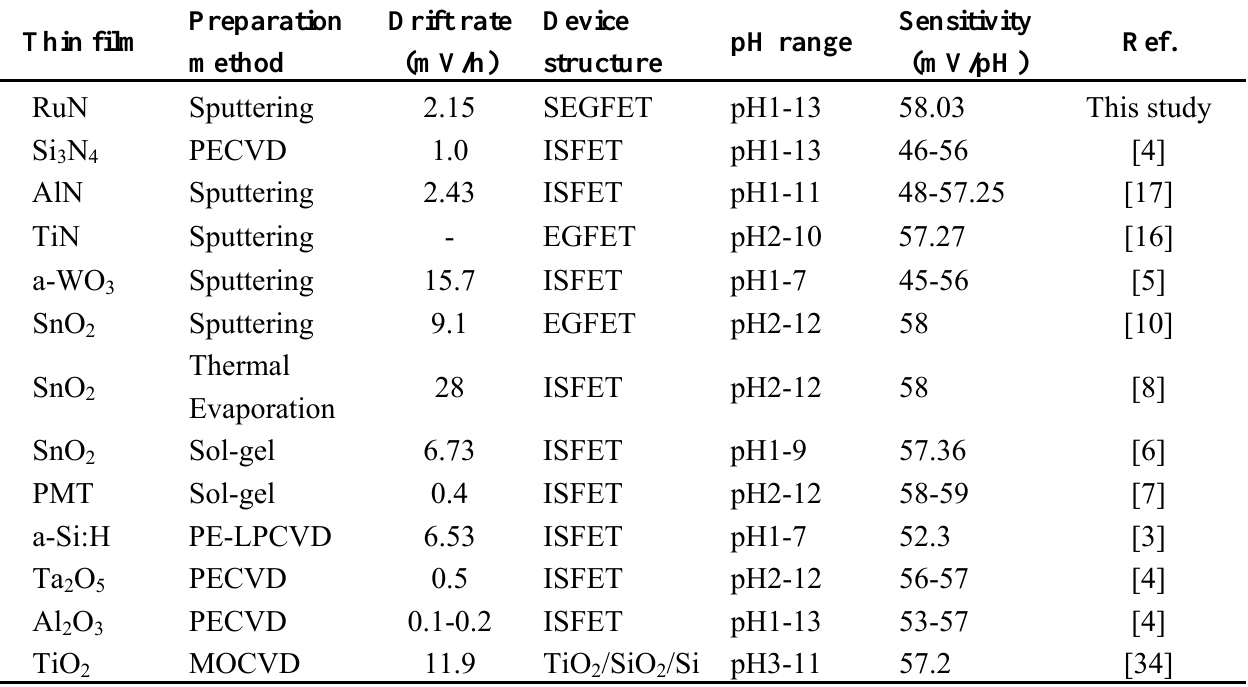
Table 1. Comparison of sensitivity, pH range and drift rate with other nitrides and different thin